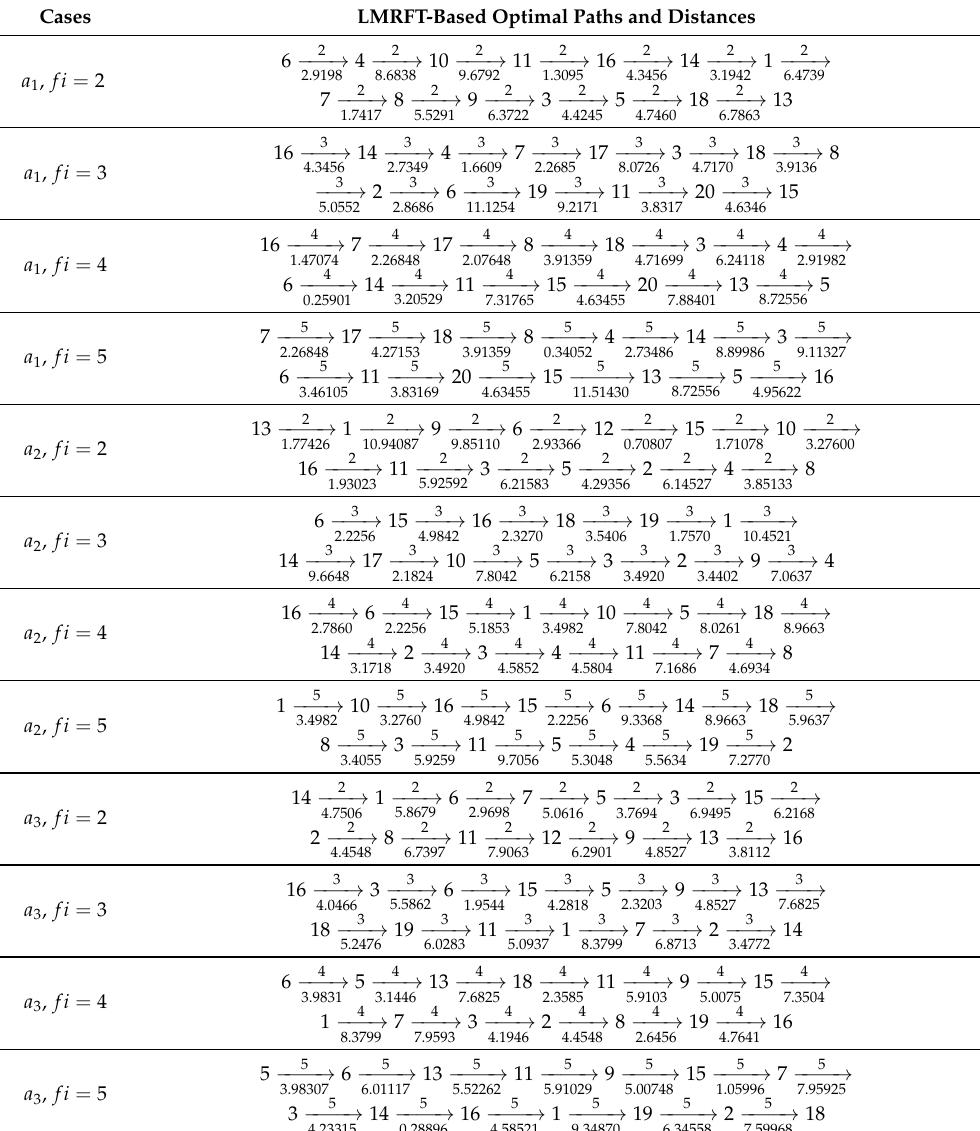
Table 3. LMRFT-based optimal paths and distances for animal 1, 2 and 3 under foraging radial levels 2, 3, 4 and 5.